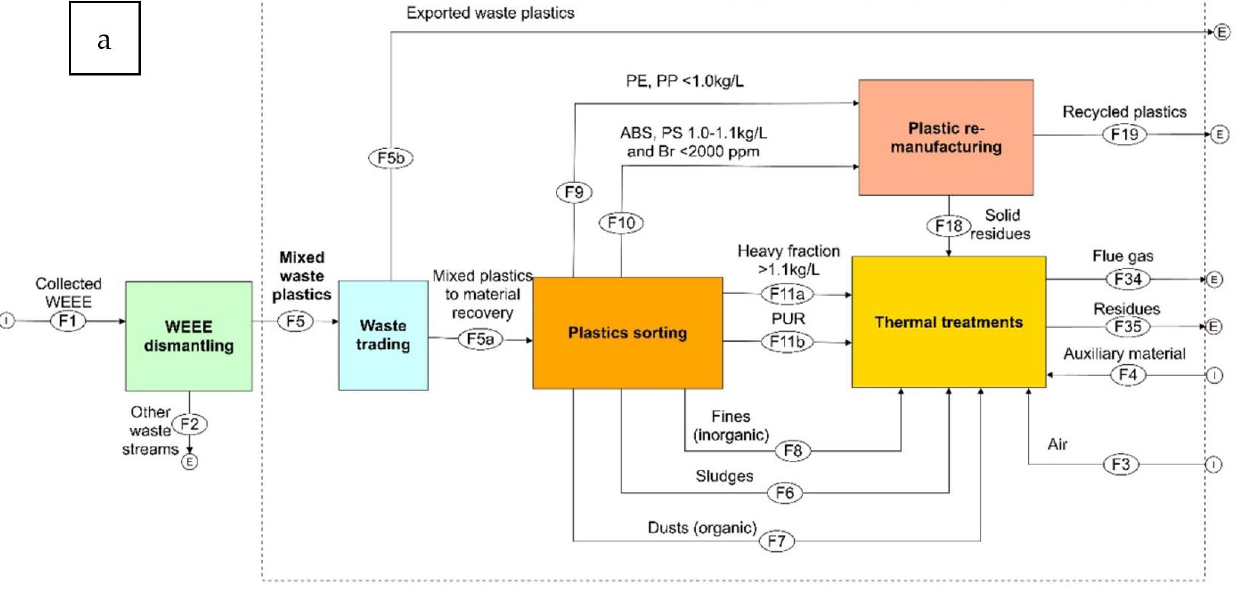
Figure 32. Comparison of the ( a ): current and ( b ): novel management pathways for WEEE plastics. Reprinted with permission from ref. [92].